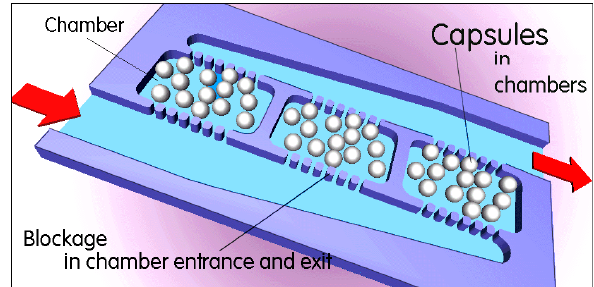
Fig. 4 Detail of one of the channels in the textile material with sub-millimetre size capsules for heating and cooling by latent heat input and removal into and from air flow through the textile pores (in principle not strictly necessary, but useful for removal of the wearer’s perspiration humidity and increase the heat transport